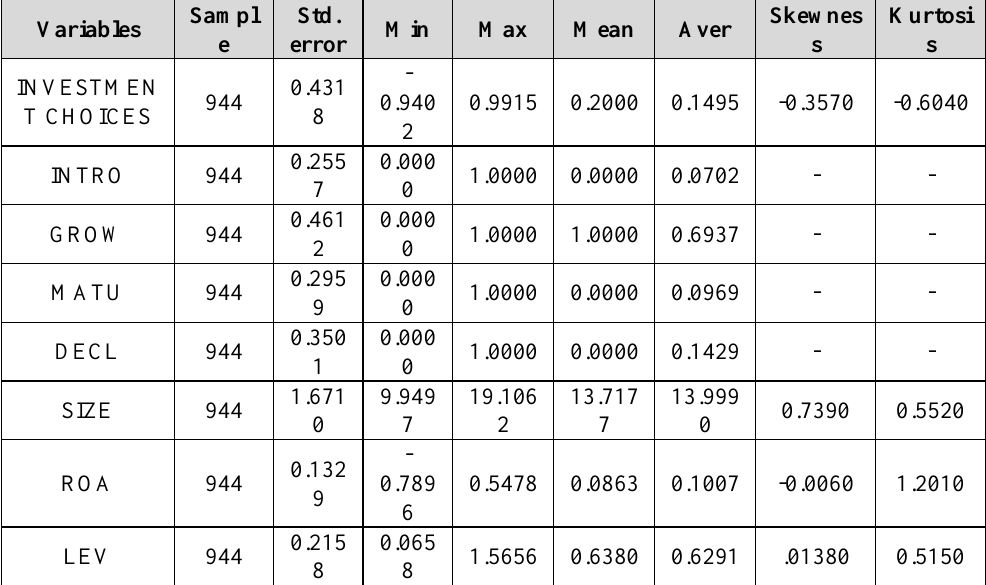
Table 1. Descriptive statistics- of research